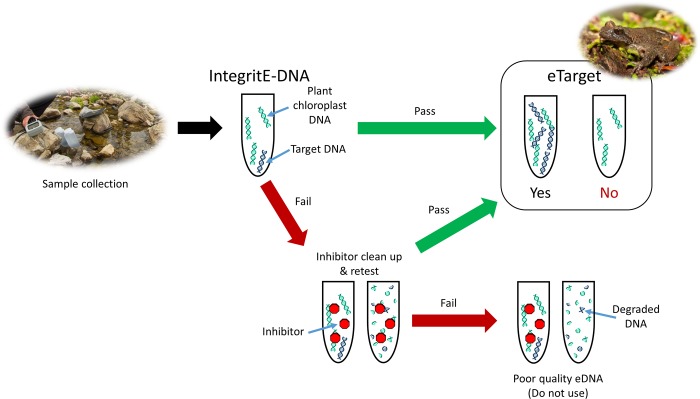
Use of the IntegritE-DNA test leads to increased confidence of species-specific DNA (eTarget) results.The IntegritE-DNA test evaluates the ability of the isolated DNA in a sample to amplify plant chloroplast DNA prior to testing for the target species. If the sample passes the IntegritE-DNA test, then it is then tested for the target species (eTarget). If a sample fails the IntegritE-DNA test, it undergoes clean-up to remove inhibitors before being retested. If the cleaned up sample fails the IntegritE-DNA test, it is deemed poor quality due to either degraded DNA or retention of inhibitors and the sample is not considered reliable. Photo credits: Jared Hobbs.